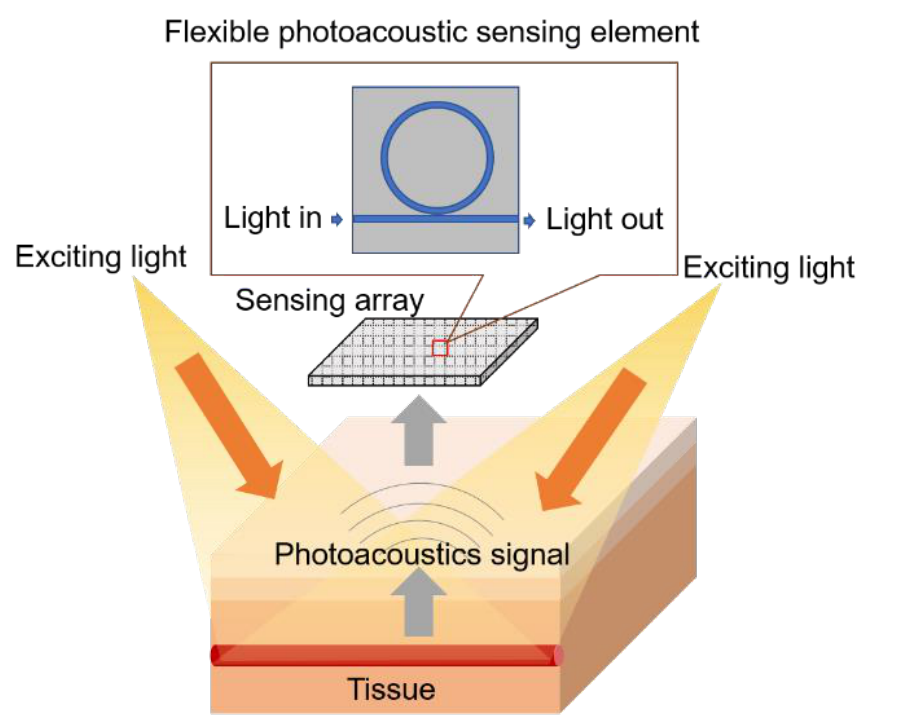
Figure 3. Flexible electronic device for photoacoustic sensing.